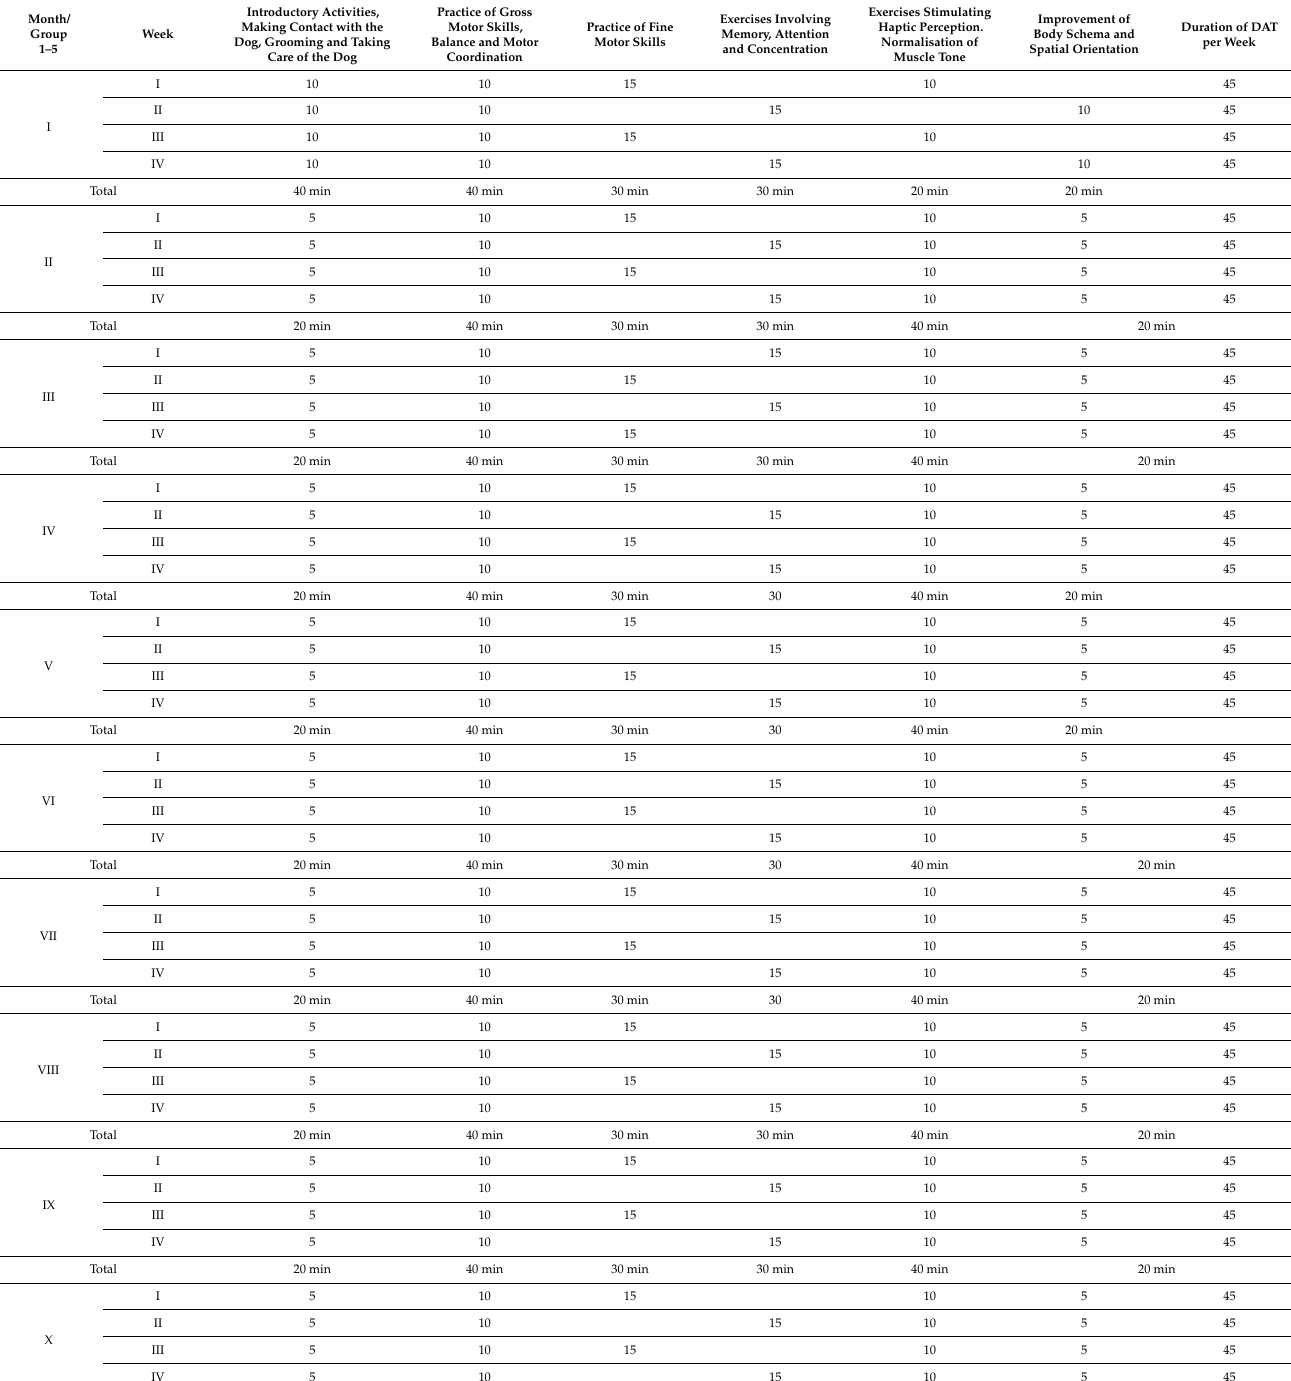
Table 1. Description of Dog-Assisted Therapy (DAT)